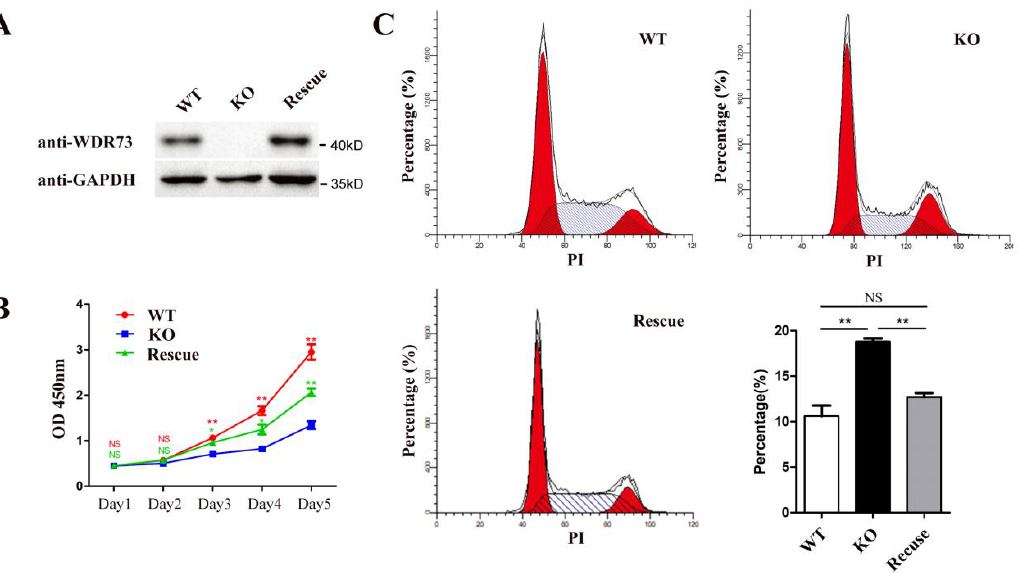
Figure 1. WDR73 KO cells are arrested in G2/M phase which can be rescued by WDR73 knock-in. ( A ) Expression of WDR73 in WT, WDR73 KO, and rescued cells; ( B ) growth curve of WT, WDR73 KO, and rescued cells; ( C ) cell cycle of WT, WDR73 KO, and rescued cells. The percentage of G2/M was calculated (** p < 0.01 ( t -test), n = 4, error bars represent mean ± SEM). NS: not